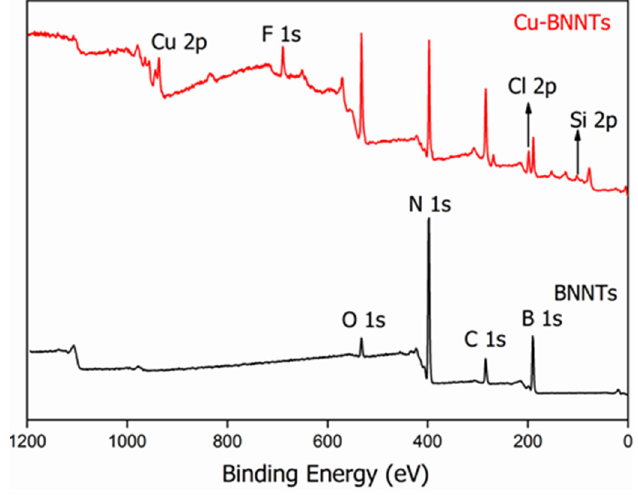
Figure 4. Survey XPS spectra for BNNTs and Cu-BNNTs.